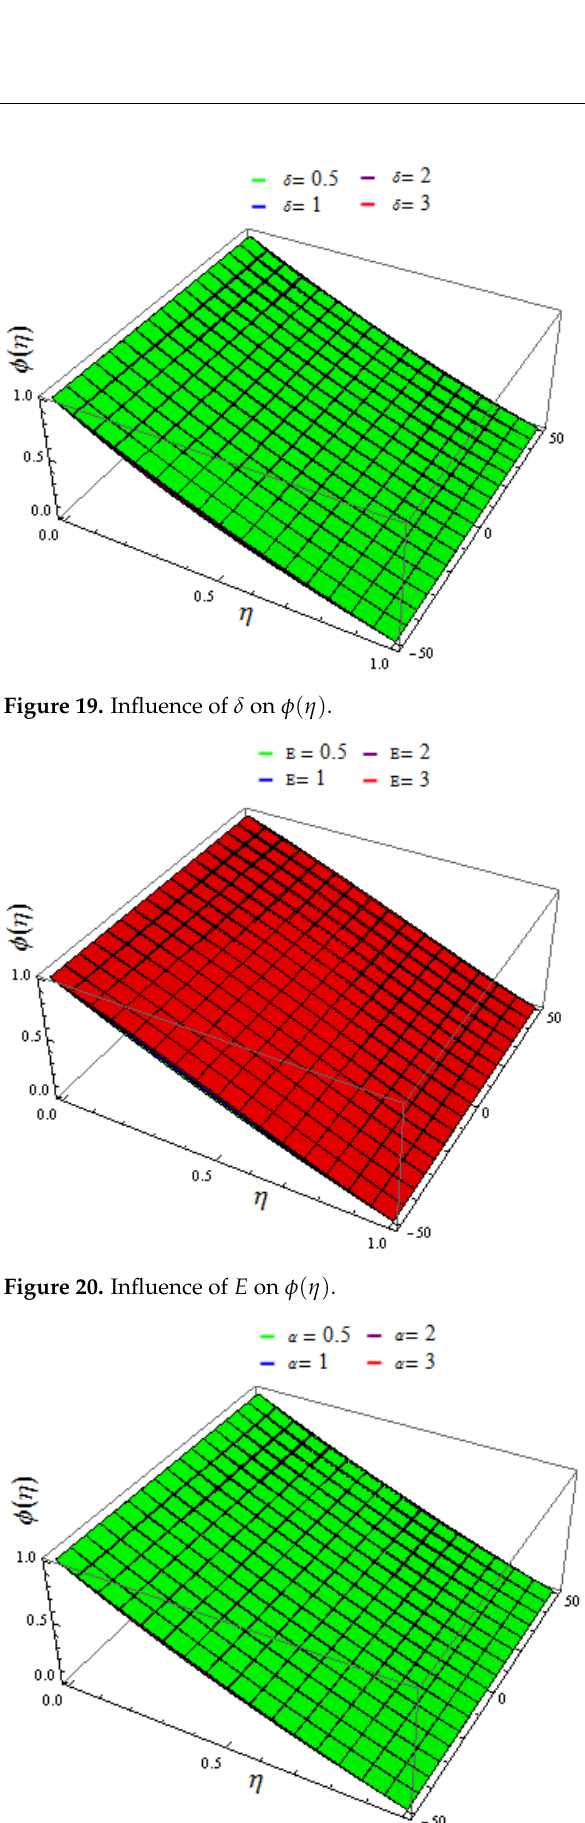
Figure 21. Influence of 𝑎 1 on 𝜙(𝜂) .